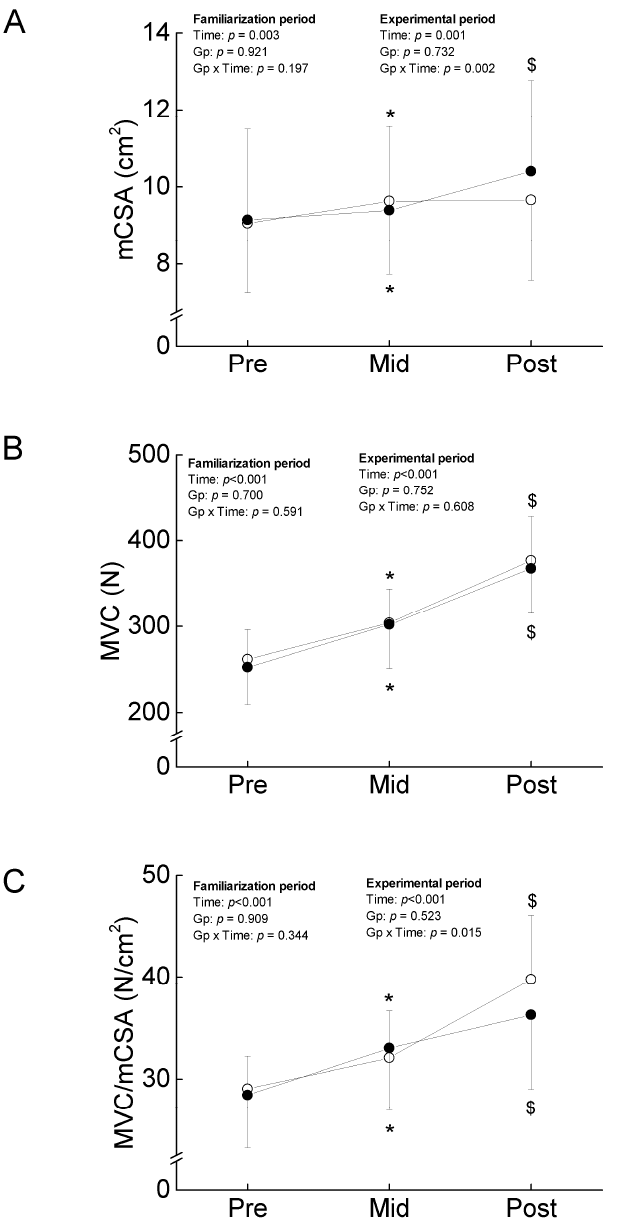
Figure 2. Training-induced changes in muscle cross-sectional area (mCSA) ( A ), maximal voluntary isometric contraction (MVC) ( B ), and MVC/mCSA ( C ) of the elbow flexors through the intervention. The filled and open circles denote COMB and ST, respectively. *, significant difference compared to Pre; $, significant difference compared to Mid.